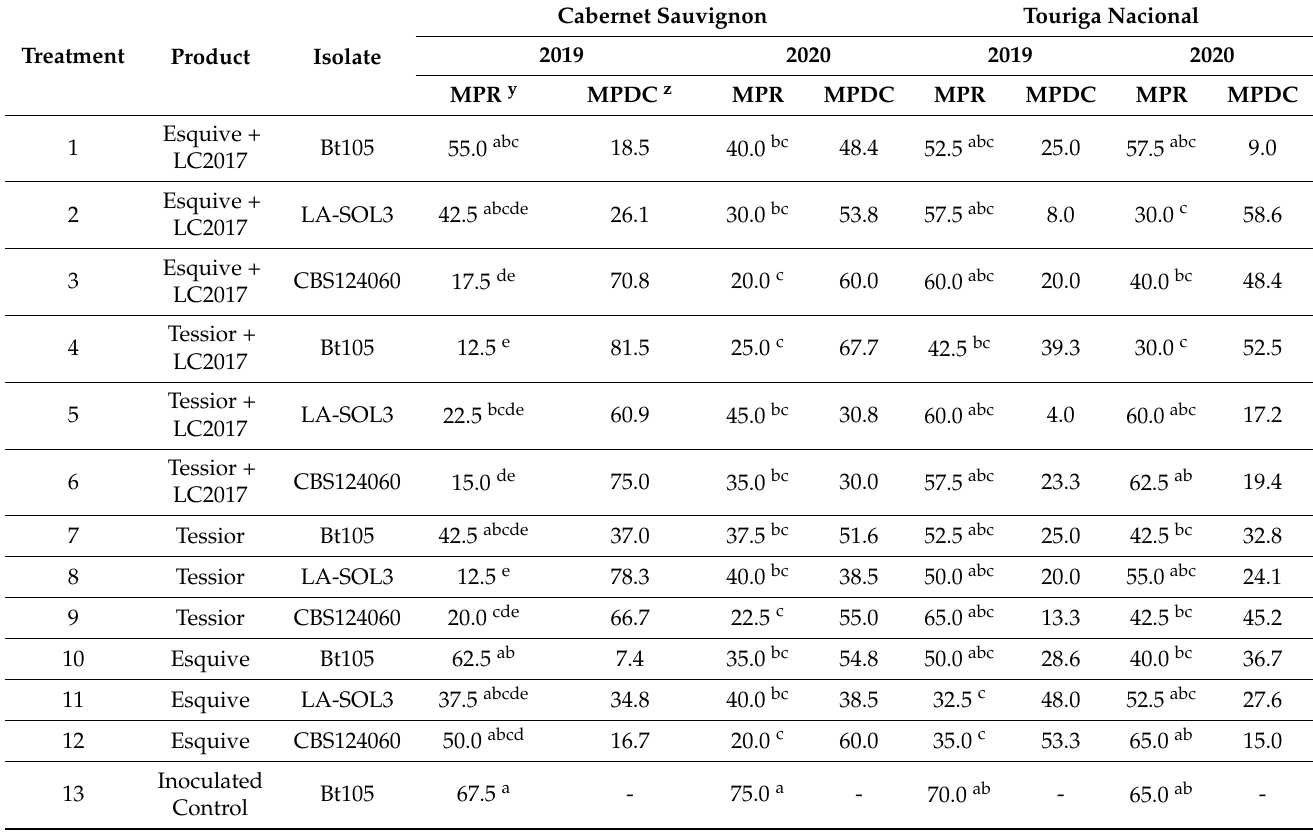
Table 2. Efficacy of treatments used solely as pruning wound protectants and in a combination with the copper-based product, LC2017, to reduce Lasiodiplodia sp. as part of an integrated disease management. Cabernet Sauvignon Touriga Treatment Product Isolate